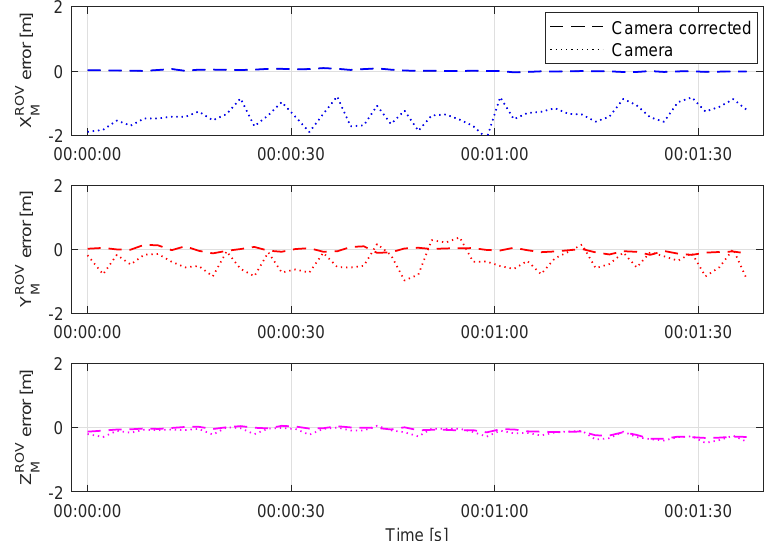
Figure 9. Relative position error of visually estimated pose before and after correction during the static test. The error in Z ROV